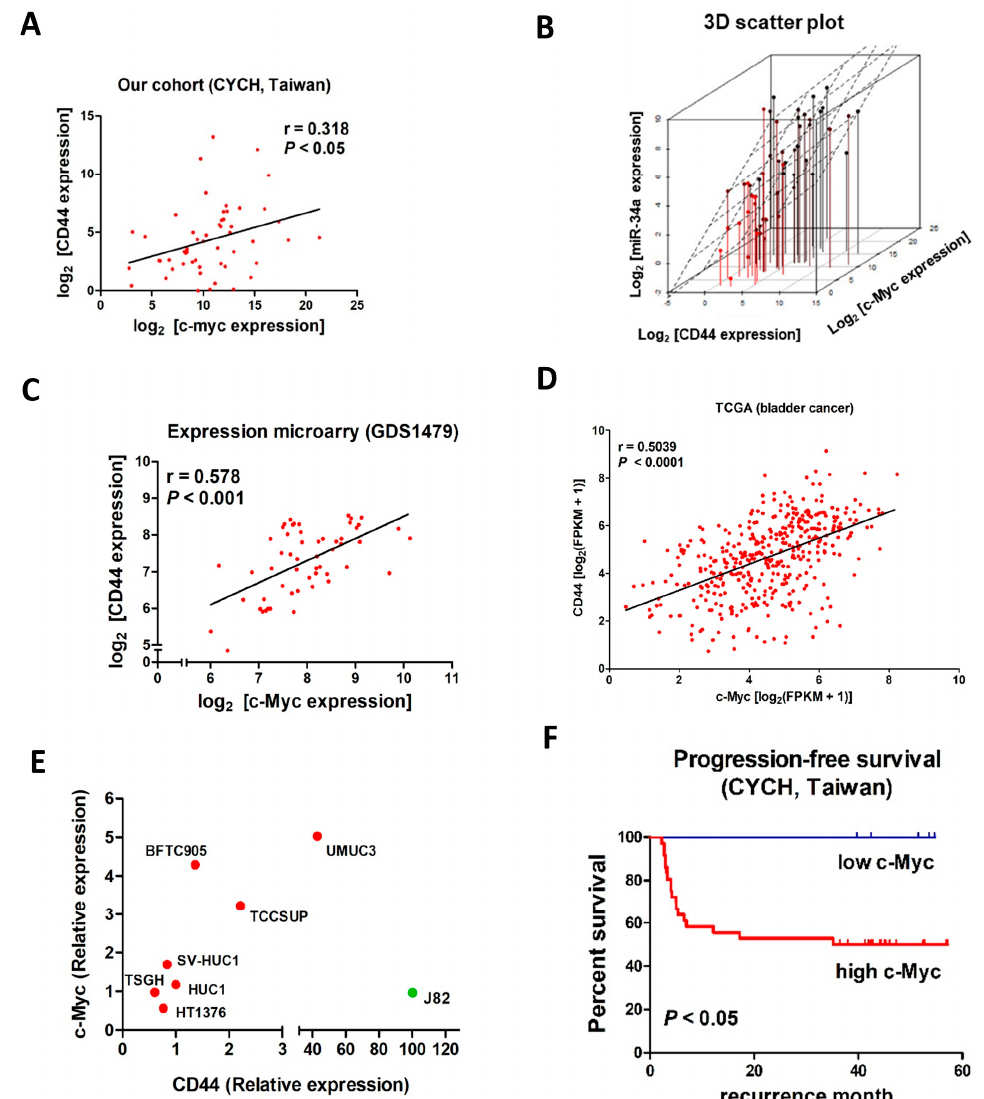
Figure 6. Positive correlation between c-Myc and CD44 expression in samples from urothelial carcinoma patients. ( A ) Scatter plot analysis revealed a positive association between the expression of c-Myc and CD44 ( r = 0.318, p < 0.05) in samples obtained from 55 UC cancer patients at Chia-Yi Christian Hospital (CYCH), Taiwan. ( B ) 3D scatter plot showing positive correlations between c-Myc , CD44 , and miR-34a in this cohort of UC patient samples. A positive correlation between the expression of c-Myc and CD44 was also observed in samples obtained from two publicly available databases ( C ) GEO GDS1479 (60 samples, expression microarray, r = 0.578, p < 0.05) and ( D ) TCGA (411 samples, RNA-Seq, r = 0.5039, p < 0.001). ( E ) Scatter plot showing the expression CD44 in UC cell lines. Except for J82 cells (green dot), which showed an exceptionally low expression of c-Myc , all other cells showed a positive correlation between expression of these genes ( r = 0.672). ( F ) Kaplan–Meier survival analysis indicating that higher c-Myc expression associates with poor recurrence-free survival ( p < 0.05). Table 1. Correlation between the expression of miR-34a , c-Myc , CD44 , and clinical-pathological data in 55 UC samples.